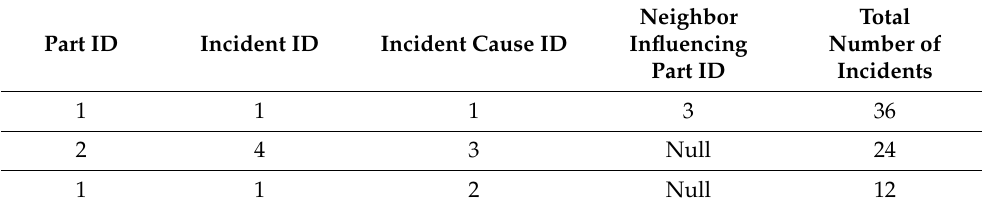
Table 4. Examples of the SQL query results.